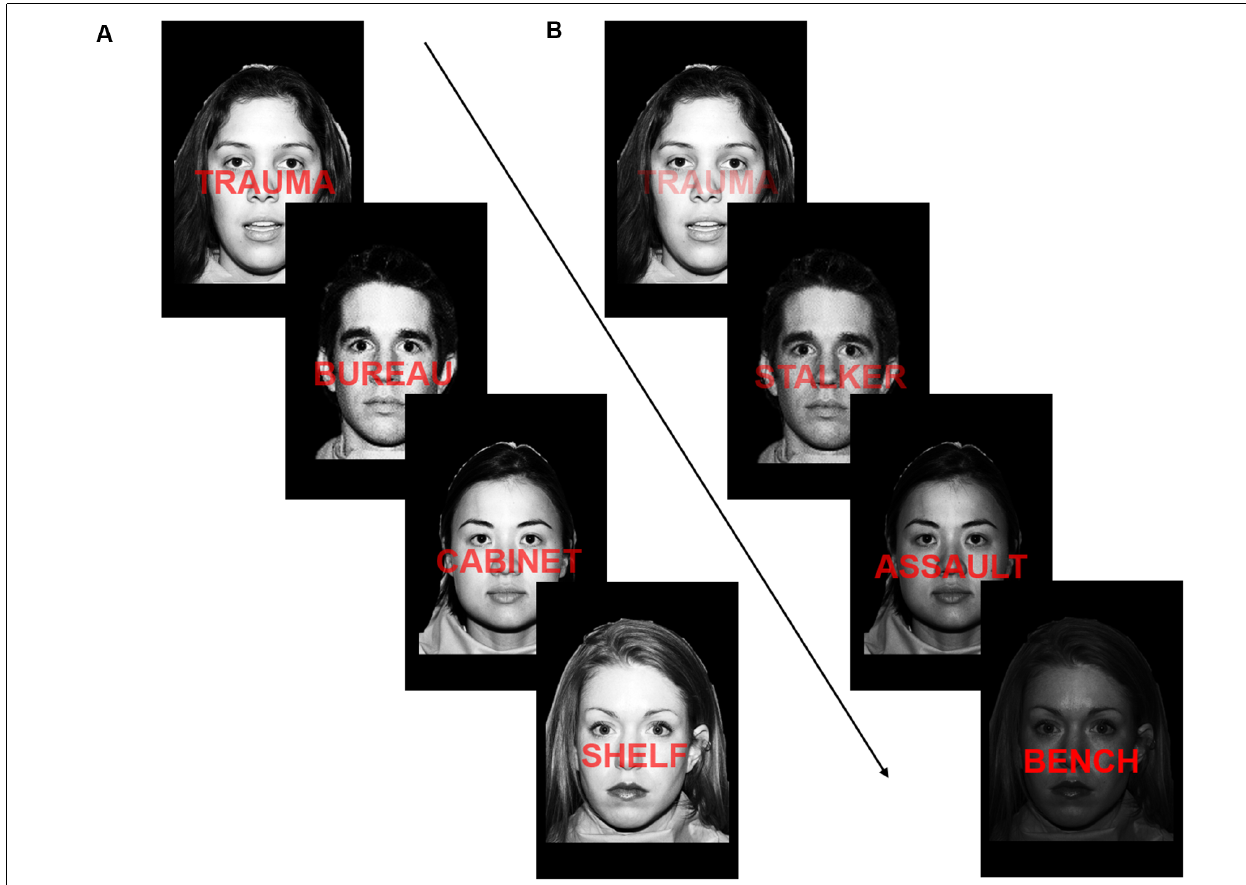
FIGURE 1 | Depiction of the implicit emotion regulation task. (A) Example of the task during training runs. Face and word opacity remained static throughout training runs. (B) Example of the task during testing runs. On each trial, the opacity of the face or word changed in response to the degree to which a participant’s brain state matched the task instruction (“attend-to-word” or “attend-to-face”) on the previous repetition time (TR). Reproduced/Adapted from the NimStim Face Stimulus set with permission.